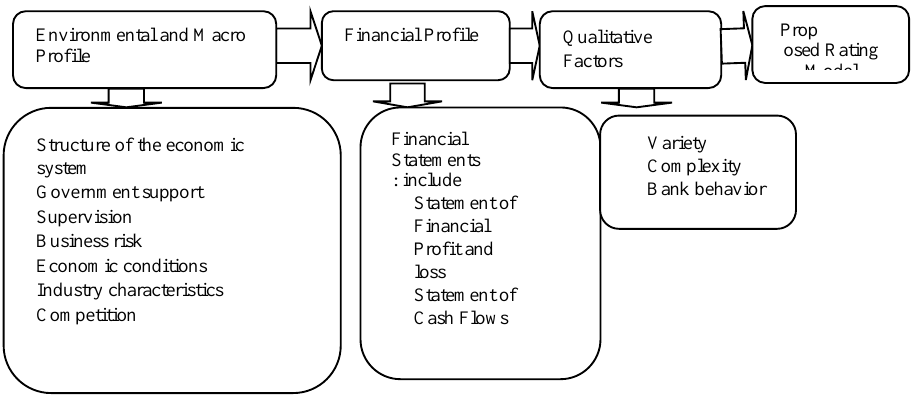
figure 1. The framework of the Rating Model